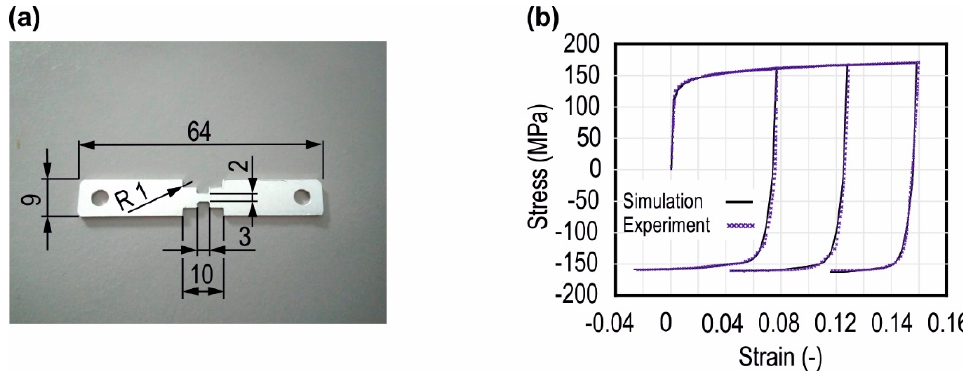
Figure 5. ( a ) Geometry of the tension-compression specimen. ( b ) Comparison of the stress–strain curves for optimal